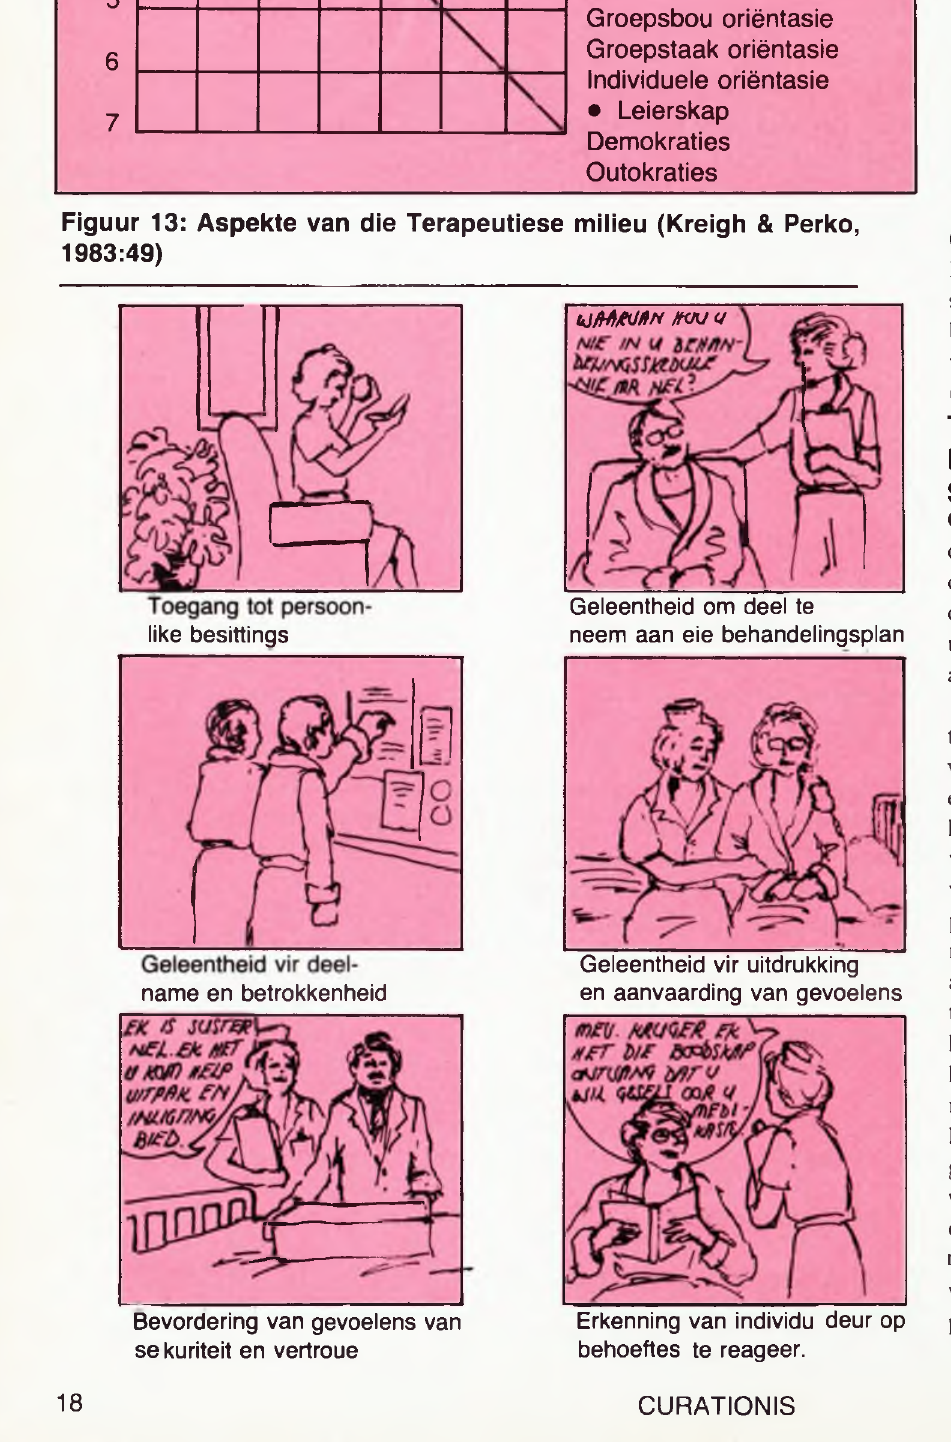
Figuur 13: Aspekte van die Terapeutiese milieu (Kreigh & Perko, 1983:49)